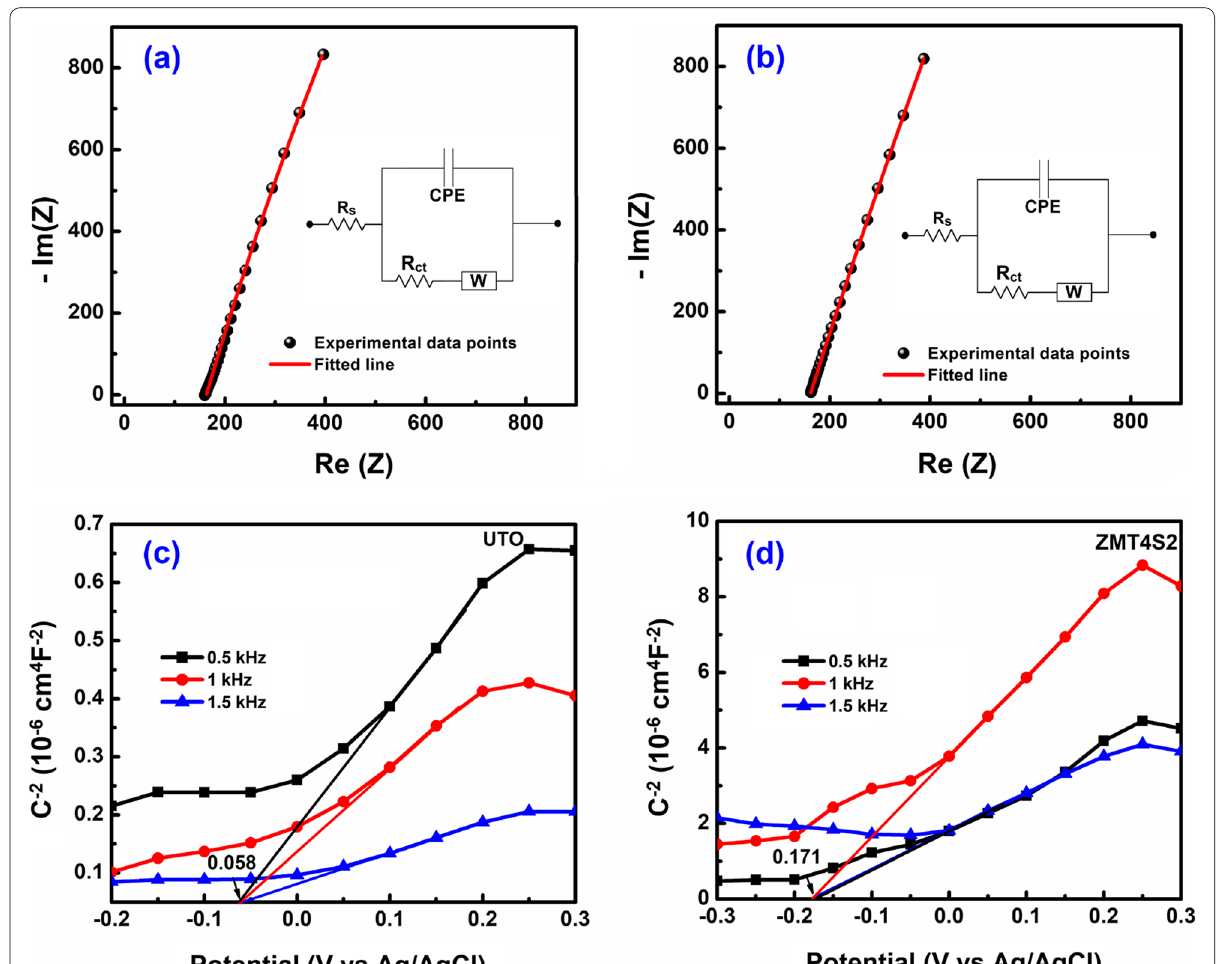
Fig. 8 Complex plane impedance plot and fitted equivalent circuit diagram of a UTO and b ZMT4S2 and Mott- Schottky function plot with flat band potential for c undoped TiO 2 (UTO), and d ZMT4S2